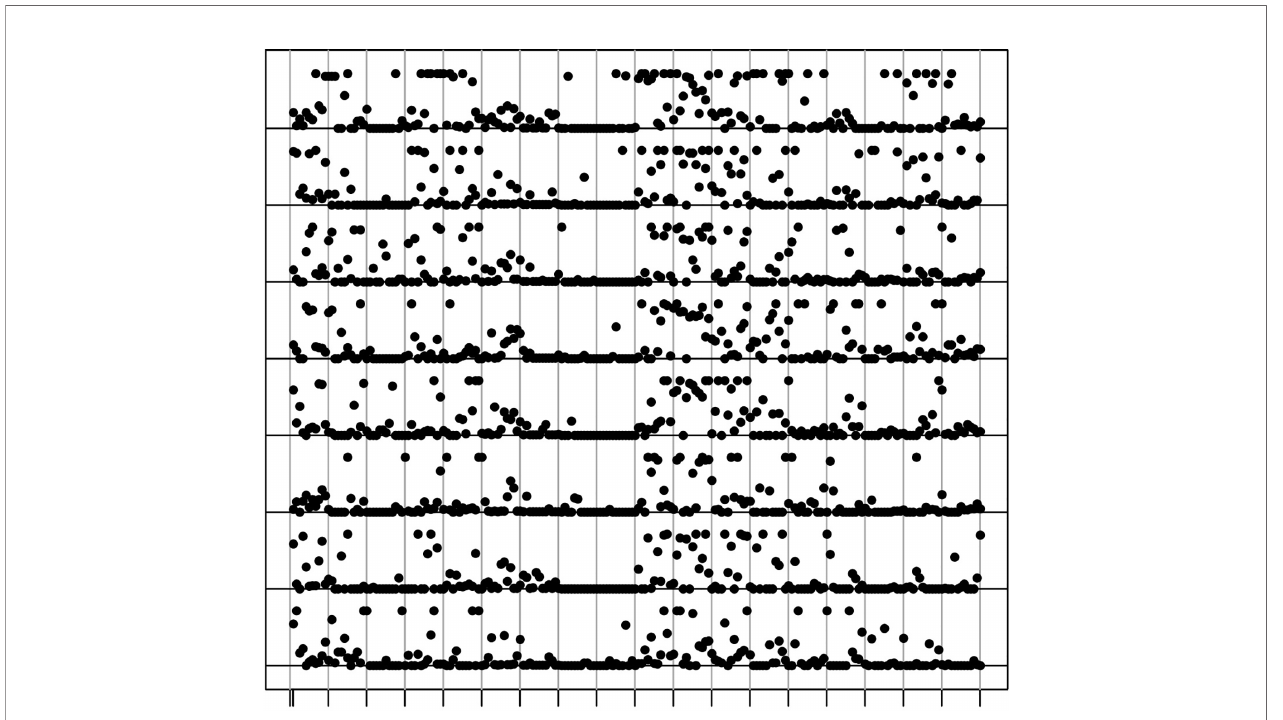
FIGURE 6 | The same data as in the parallel heatmaps is shown here in the form of stacked curves. Each of the curves shows the mutant fractions for a slice with a fi xed x-coordinate slice. The horizontal axis refers to the sites in the ( y , z ) slices. The vertical lines and the tick marks partition the axis in 18 intervals, with each interval having a fi xed z-coordinate. Here, both a direct comparison of samples with fi xed x-coordinate as well as the comparison across the different x-values is